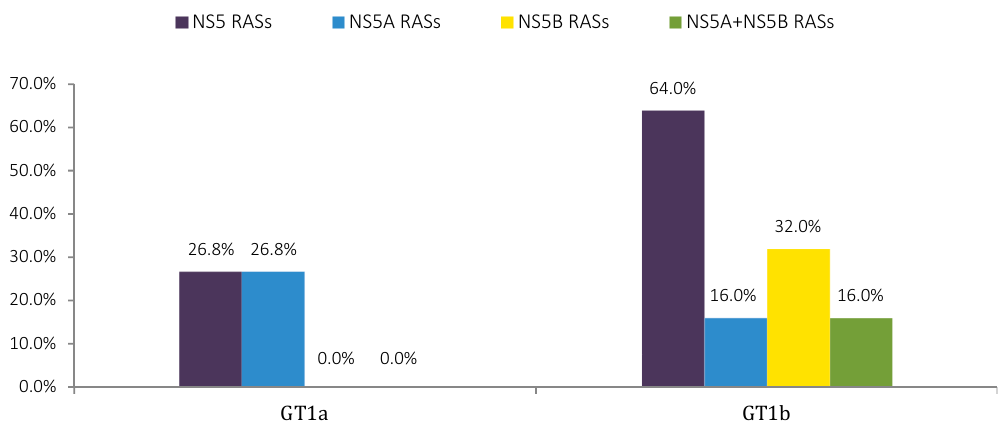
Figure 3. Percentage of HCV-infected patients with NS5 RASs, according to subtype. Substitution analyses were conducted on Sanger sequencing data with a 15% cut-off limit. Dual-class RASs are assigned as NS5A + NS5B RASs.